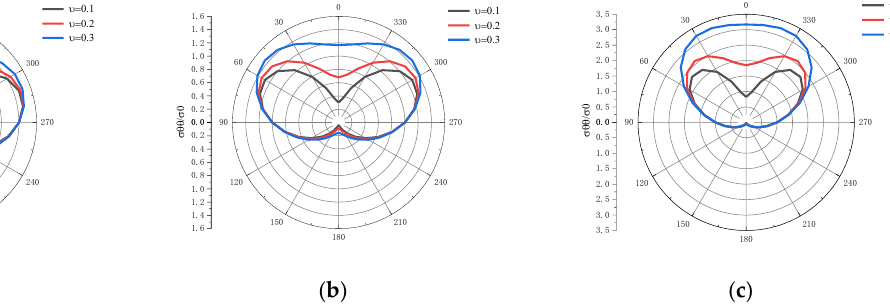
  around the surface of the cavity for / / σ 0 around the surface of the cavity for P 1  0 θθ = 0.5 k a . ( b ) = 1.0 k a 0 0